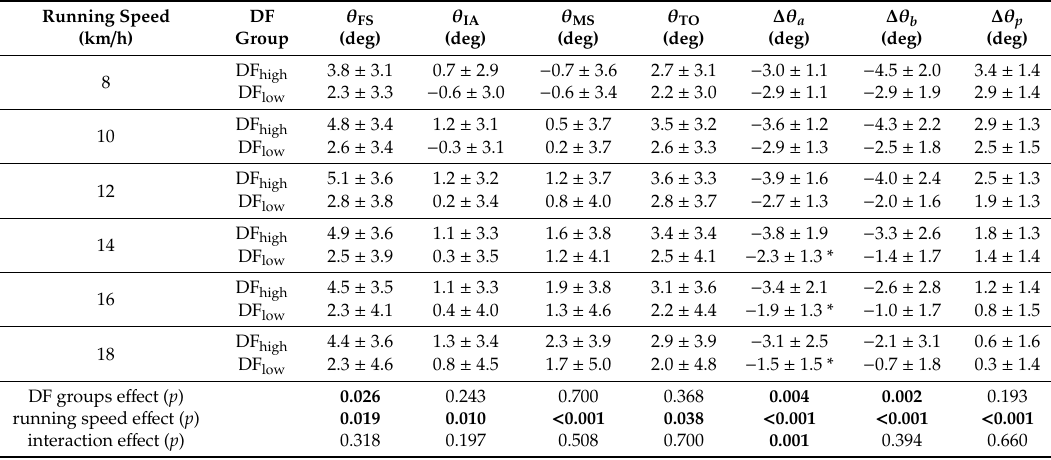
Table 6. Retroversion–anteversion of the pelvis segment angle at specific events of the running stance ( θ FS , θ IA , θ MS , and θ TO ) and their range of motions during the di ff erent running stance phases ( ∆ θ a , ∆ θ ∆ θ p ) for the high (DF high ) and low (DF low ) duty factor running groups at the di b , and running